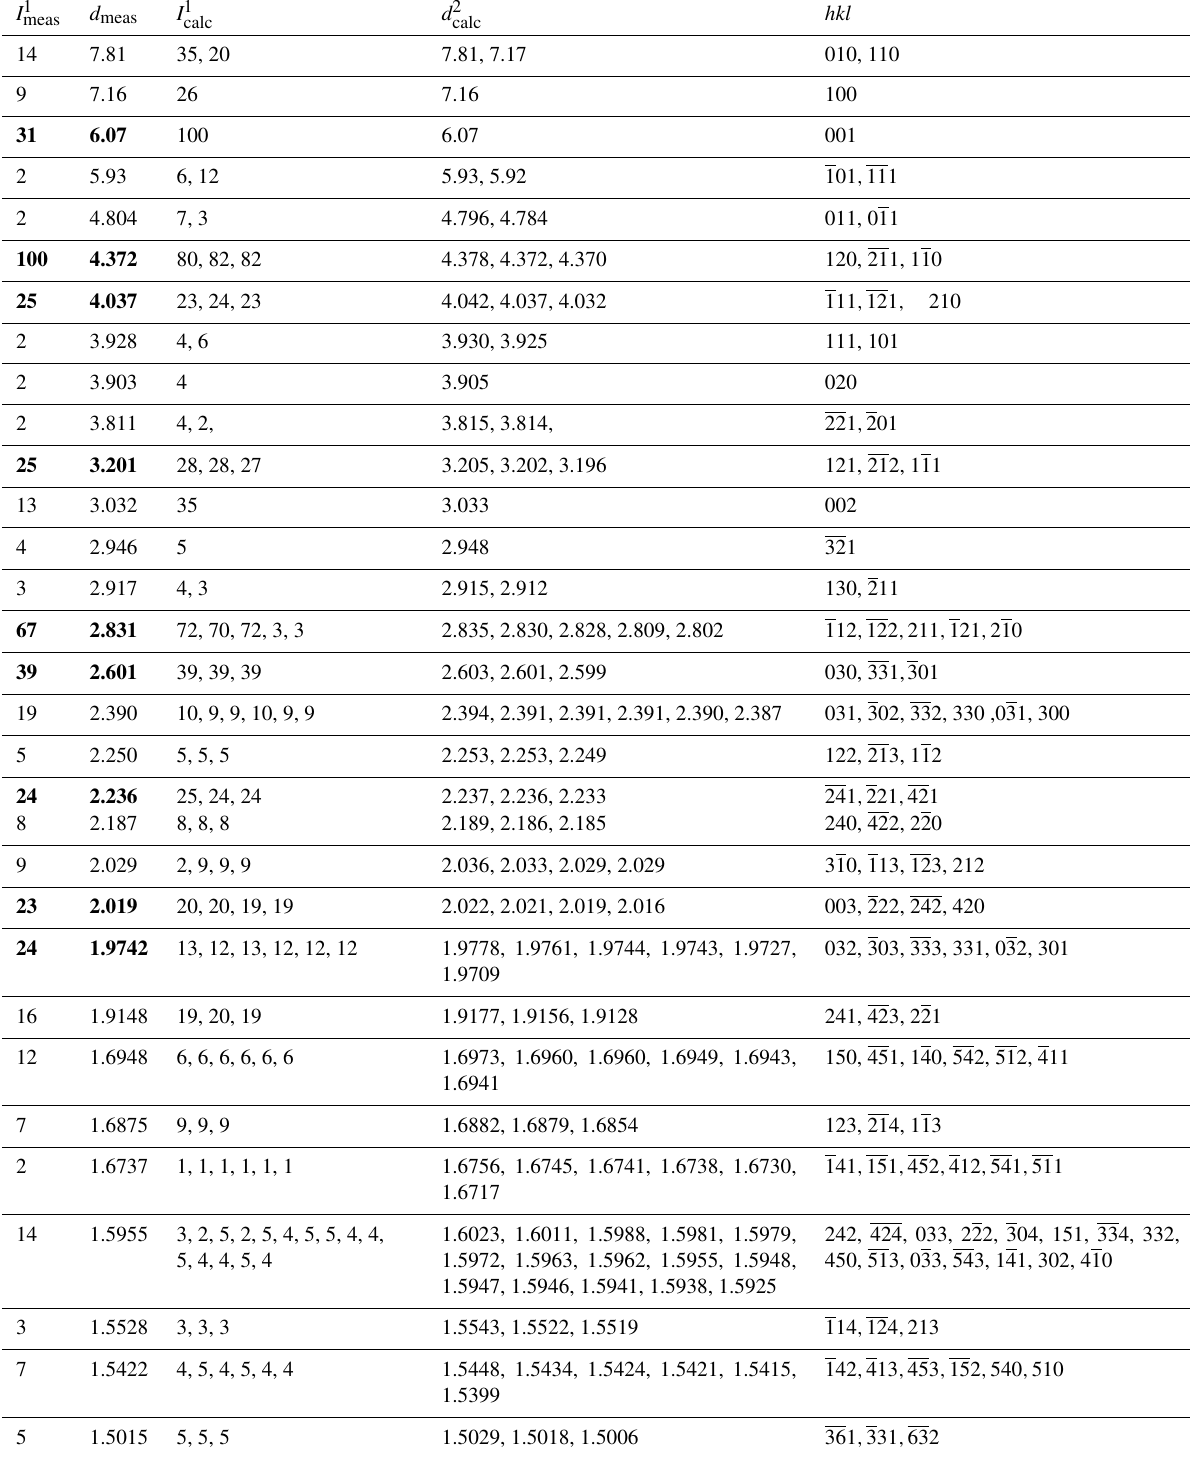
Table 2. X-ray powder diffraction data ( d in Å) for alicewilsonite-(YCe). The strongest reflections are given in